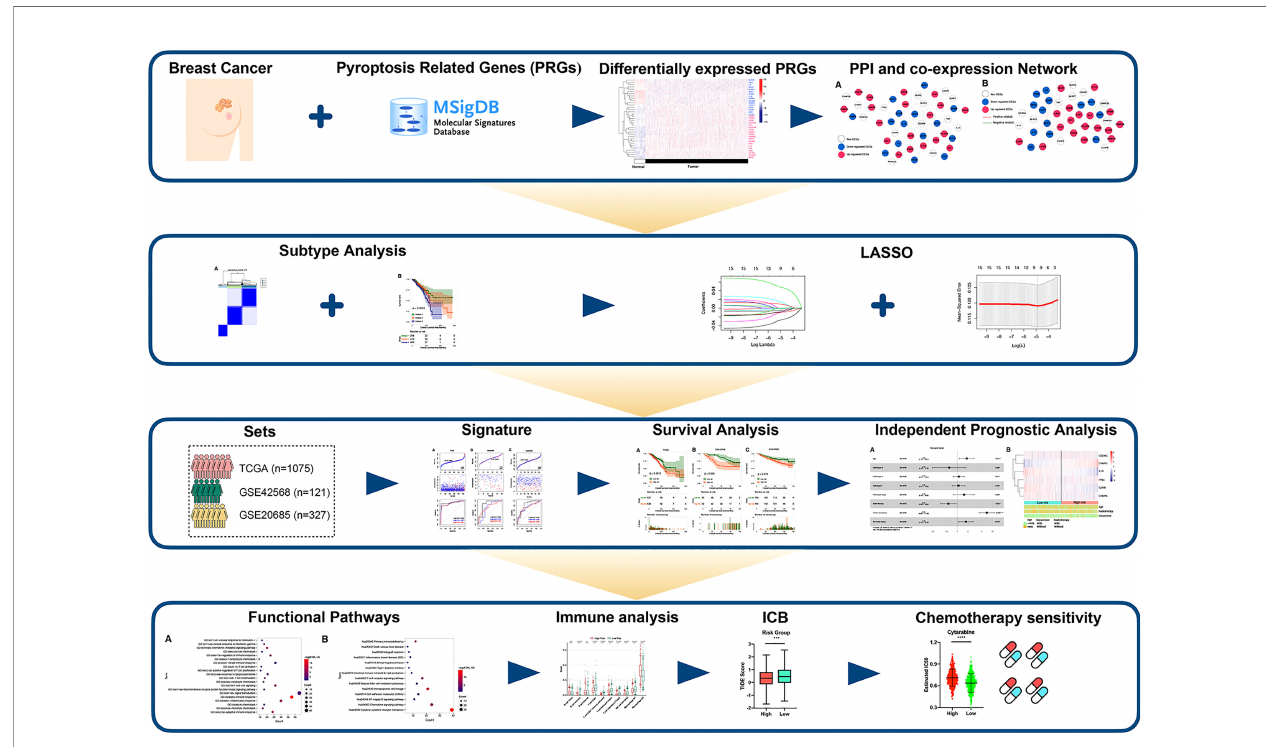
FIGURE 1 | Flow diagram of our